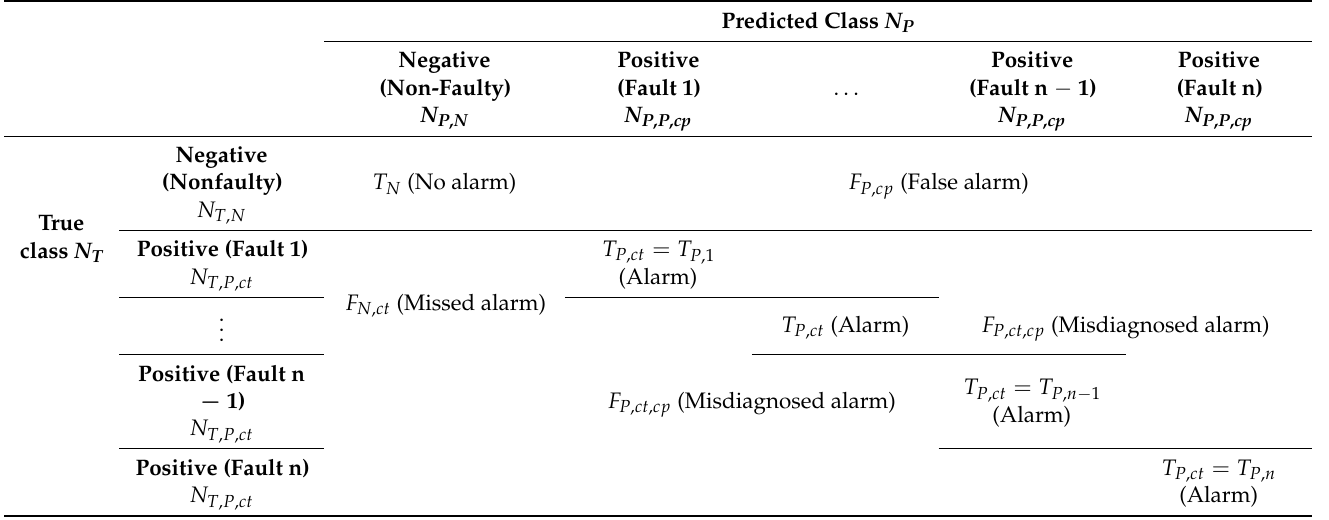
Table 10. Proposed generalized definition template for confusion matrix of FDD (multiple faulty and one nonfaulty